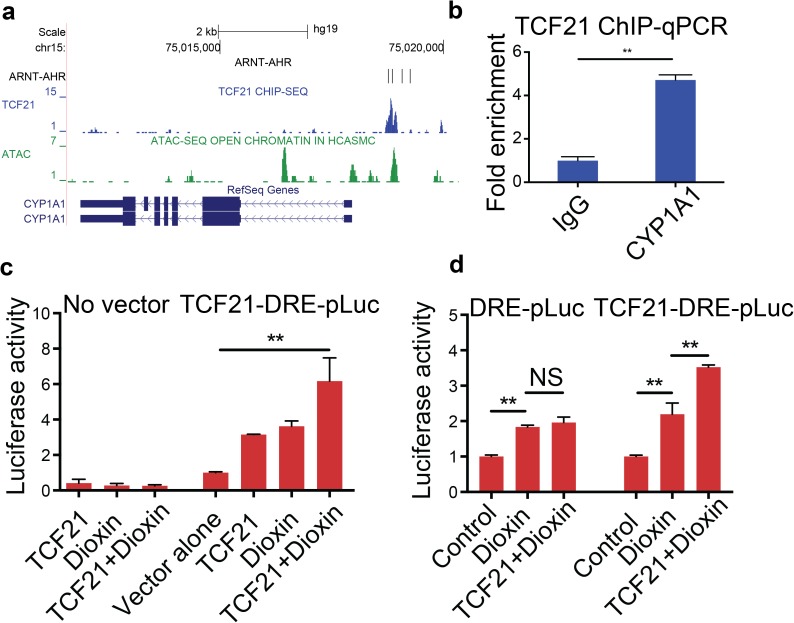
TCF21 binds in the CYP1A1 locus, and interacts with AHR to promote transcription.(a) UCSC Genome Browser view of TCF21 binding upstream of the CYP1A1 gene in a region of open chromatin as defined by ATAC-seq with a high predicted affinity for AHR-ARNT binding. (b) TCF21 binding to CYP1A1 upstream region is demonstrated with ChIP-qPCR. (c) Transfection studies with a composite TCF21-AHR binding site reporter plasmid shows additive effects on transcription with combined TCF21 expression plasmid and treatment of the cells with dioxin. TCF21-DRE-pLuc is a luciferase construct with alternating TCF21 and AHR binding motifs subcloned proximal to the promoter. DRE, dioxin response element. (d) Deletion of the TCF21 binding motif in the reporter plasmid abrogates the effects of TCF21 over-expression, verifying that TCF21 has a direct transcriptional effect in these experiments. (*p<0.05; **p<0.005).